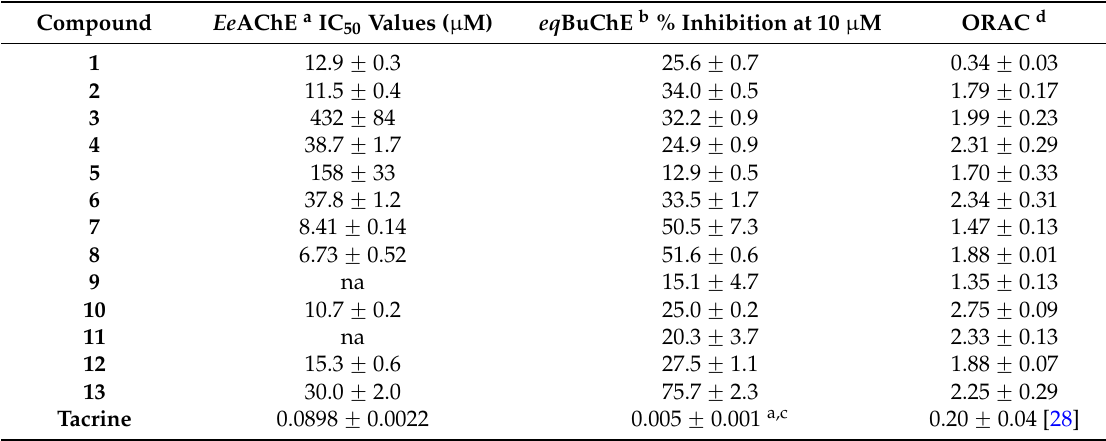
Table 1. Inhibitory potencies, expressed as IC 50 values ( μ M), for the inhibition of Ee AChE and eq BuChE, and antioxidant power of imidazopyranotacrines 1 – 13 .